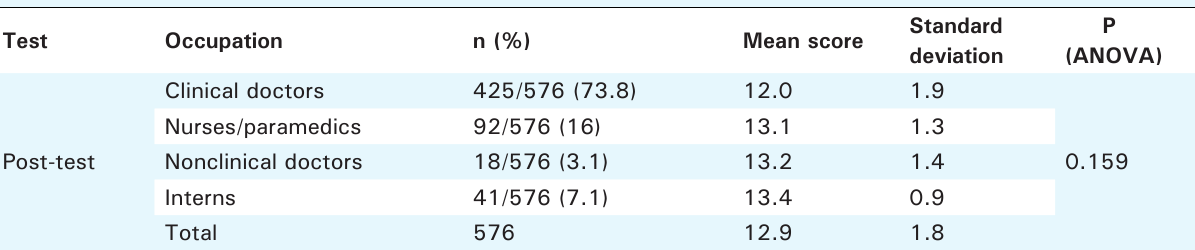
Table 1. Post- test results and occupation of the participants.